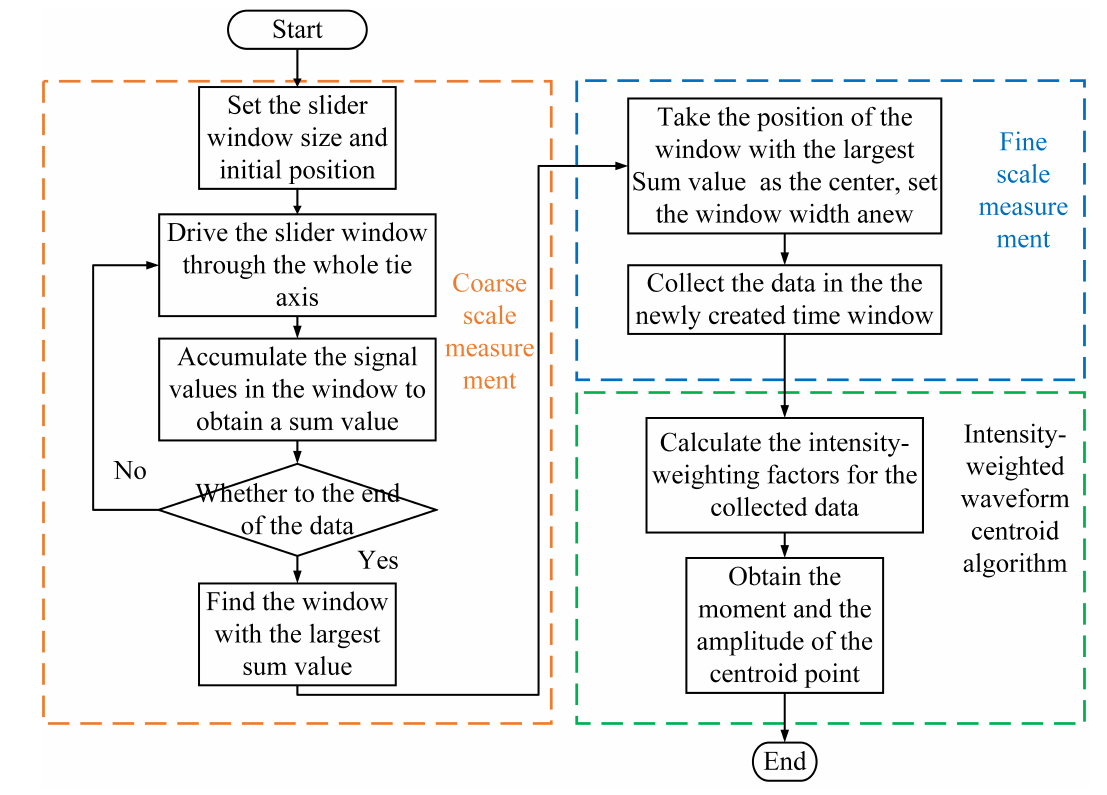
Figure 2. Flowchart of the DSIW waveform centroid algorithm.